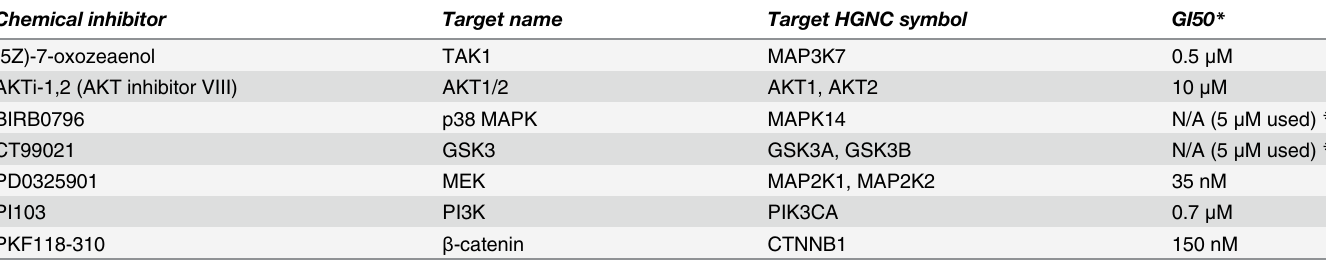
Table 1. Chemical inhibitors and their corresponding protein kinase